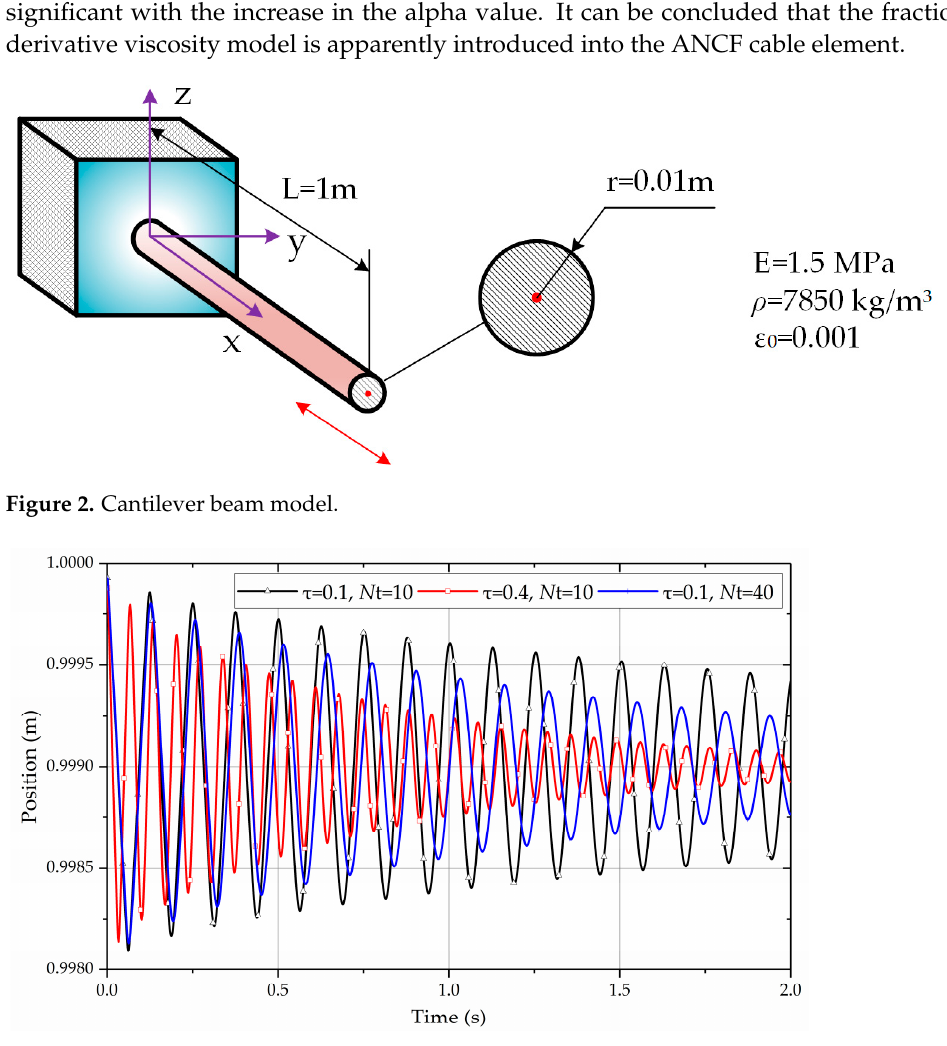
( b ) ( c ) Figure 4. x-component of the free tip position at different derivative orders. ( a ) τ = 0.1, N t = 10; ( b ) τ = 0.1, N t = 40; ( c ) τ = 0.4, N t = 10. 6.2. Flexible Pendulum In order to demonstrate the performance of the proposed cable damping model in the large overall motion and large deformation, a convergence test is performed on the flexible pendulum model shown in Figure 5. The material properties of the pendulum are given in Table 1. The simulation time is 1.5 s. The damping parameters used in this exam- ple are 10 t N = and 0.5 α= . The pendulum is discretized into 4, 8 and 16 ele- ments, respectively. The vertical displacements of the free tip and the total strain energy